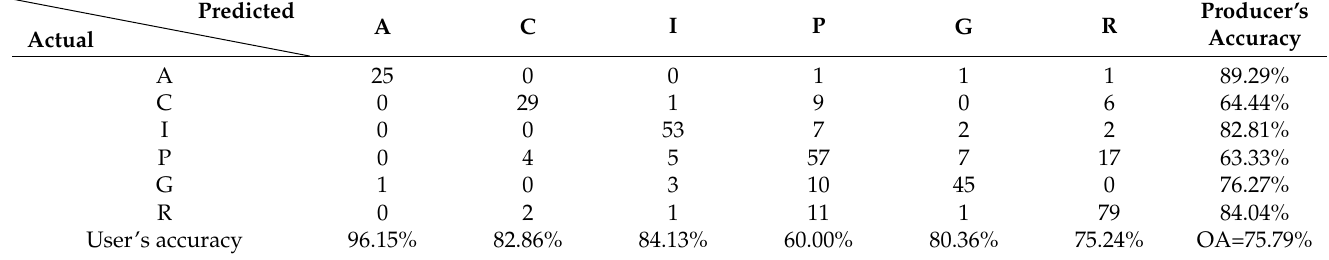
Figure 8. UFZ classification maps based on Graph SAGE model: ( a ) The UFZ map of Zhuhai; ( b ) the UFZ map of Singapore. Table 6. Confusion matrix for the test dataset in Zhuhai using Graph SAGE